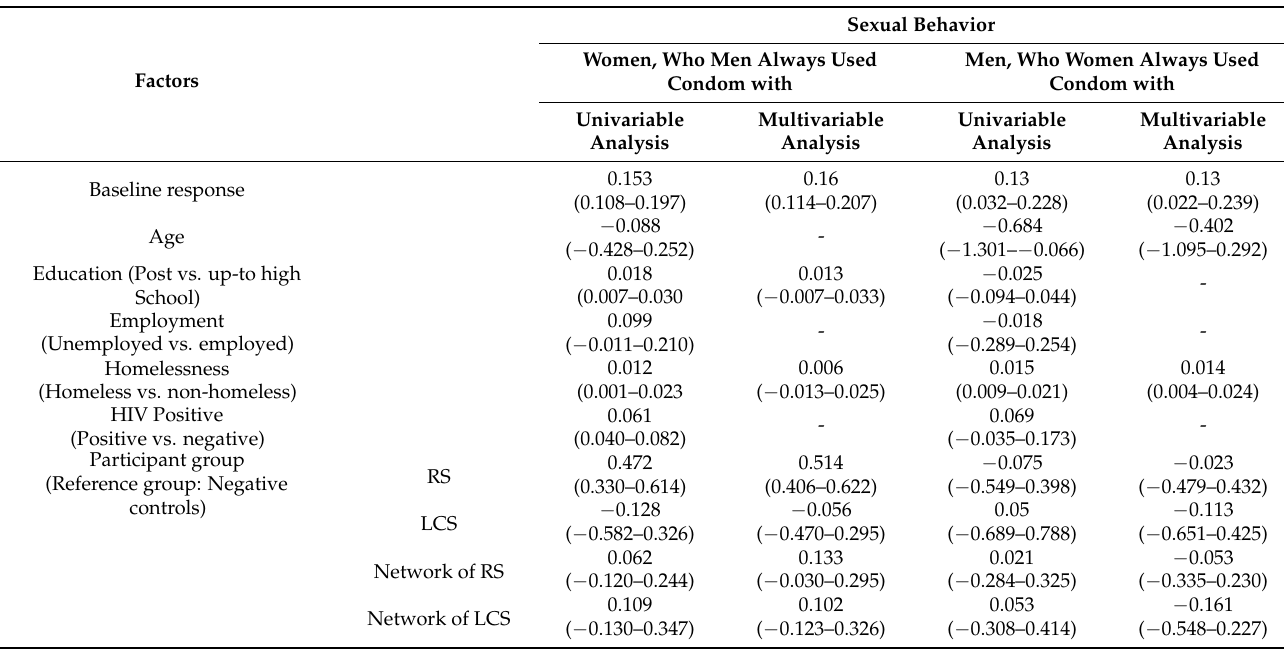
Table 4. Regression coefficients and 95% confidence intervals (CI) of univariable and multivariable fractional regression models for proportions of sex partners who heterosexual participants of TRIP had safe sex